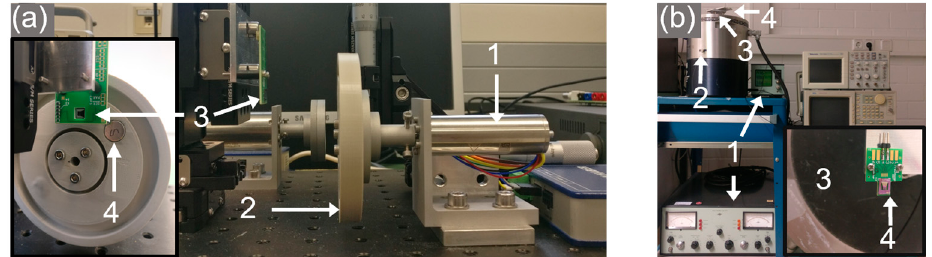
Figure 4. Excitation and measurement setups. ( a ) Pole-wheel setup: 1—motor, 2—pole-wheel, 3—harvester and 4—magnet. In the inset, the mounting of the harvester is shown from a different per- spective. ( b ) Shaker setup: 1—driver electronics, 2—mechanical exciter body, 3—movable membrane, 4—harvester. The inset illustrates the mounting of the harvester from a top view.